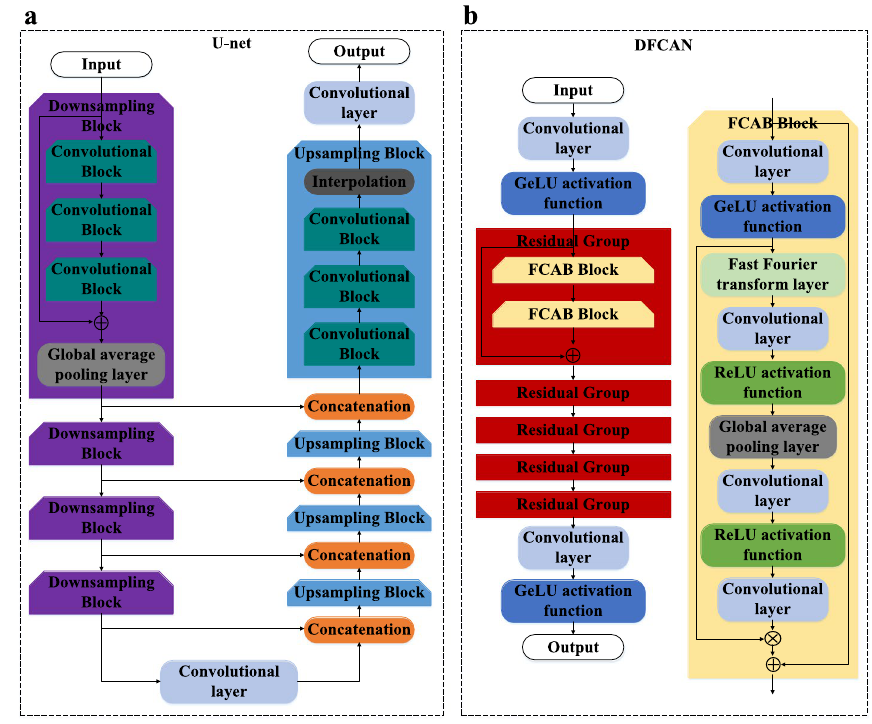
Fig. 2 The architecture of the generator of TCAN. ( a ) The architecture of U-net. ( b ) The architecture of